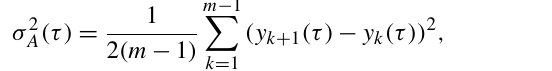
3. Using the DOAS method to fit D CE, meas (λ) and L eff (λ) · σ i (λ) , new HONO and NO 2 concentration values are